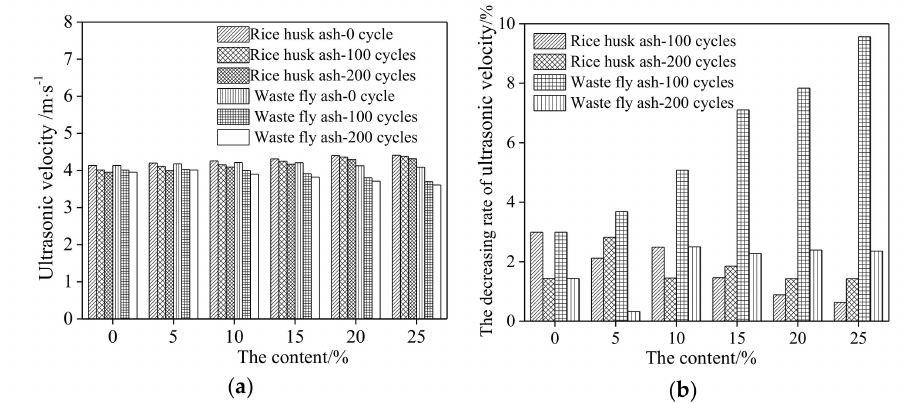
Figure 6. The ultrasonic velocity of RPC and the following increments during NaCl freeze–thaw cycles. ( a ) The ultrasonic velocity. ( b ) The increasing rate of ultrasonic velocity.